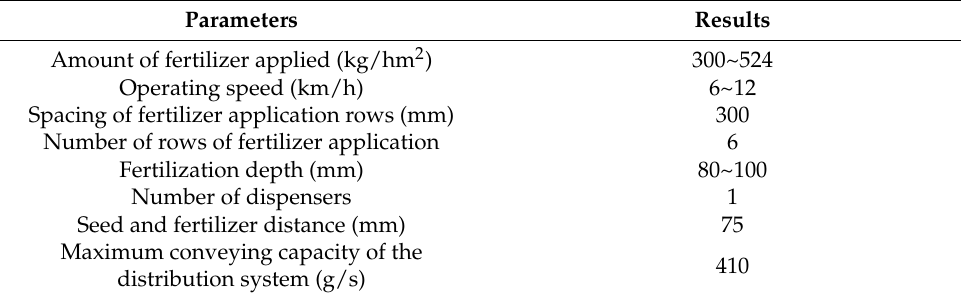
Table 1. Basic design parameters of machine.